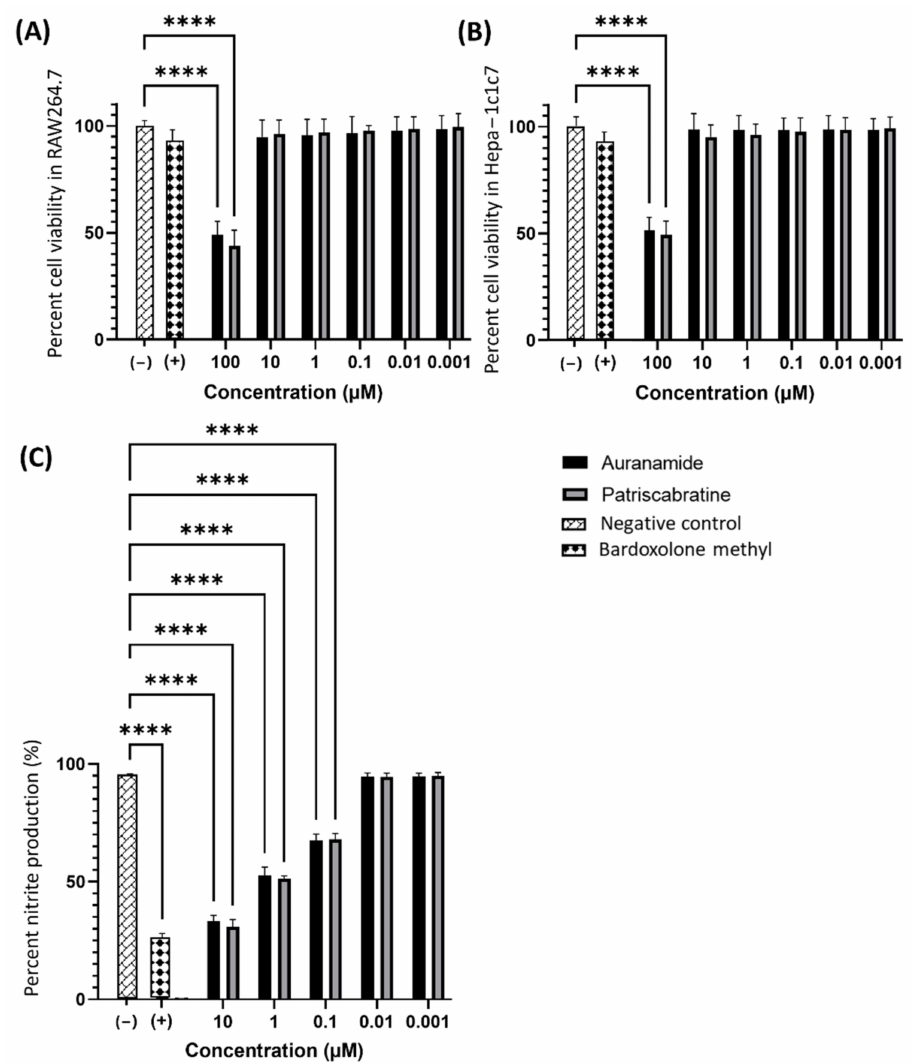
Figure 1. The cytotoxicity of test compounds on ( A ) murine macrophages (RAW 264.7); ( B ) murine hepatoma (Hepa-1c1c7) cells; ( C ) the anti-inflammatory activity of test compounds in LPS Ec chal- lenged RAW 264.7 cells. The results are expressed as the mean ± SD (n = 3). ****, p ≤ 0.0001 compared to LPS Ec treated cells. The bars without annotation indicate the values are not significant with reference to the negative